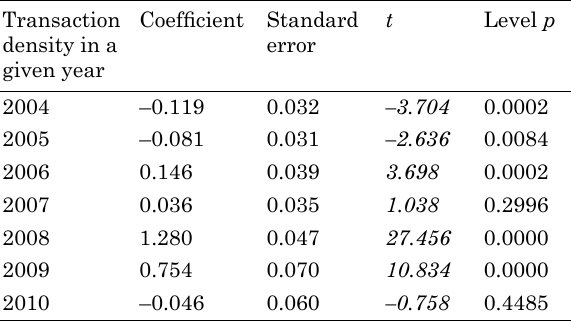
Table 3. Results of estimating a linear model of multiple regression Transaction density in a